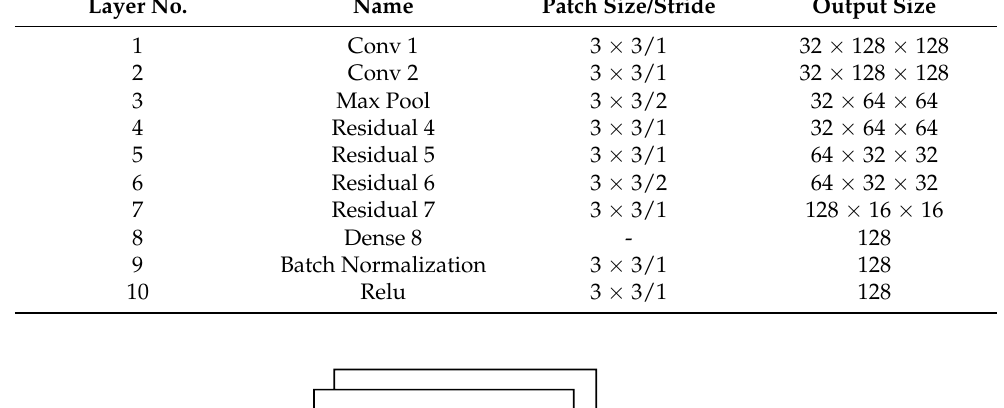
Table 2. An overview of the CNN architecture used to learn the cattle re-identification. Layer No.